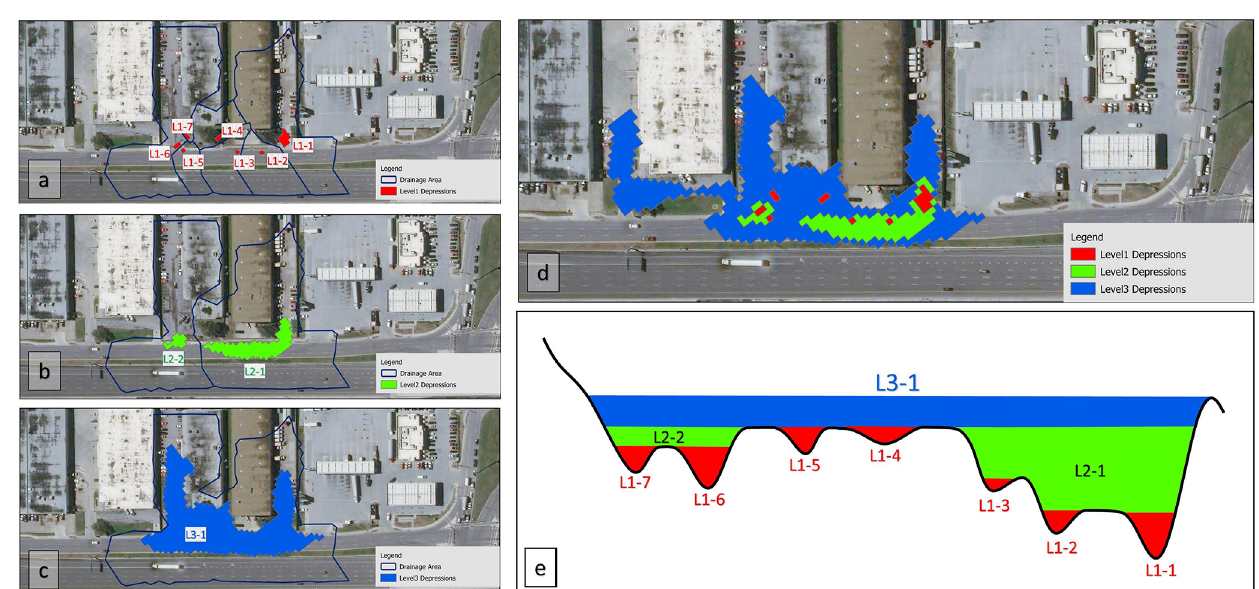
Figure 2. Hierarchical filling of surface depressions (basemap from